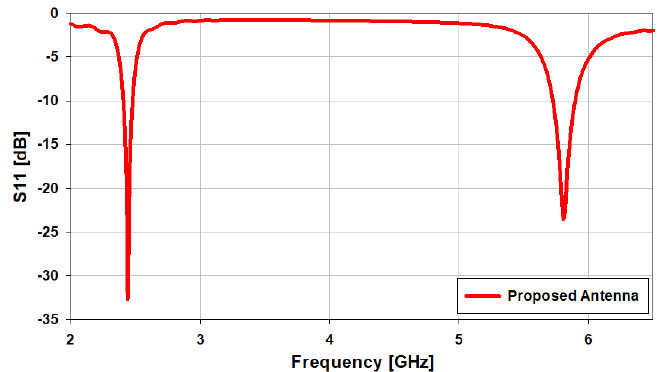
Figure 2. S 11 of the designed dual-band antenna.